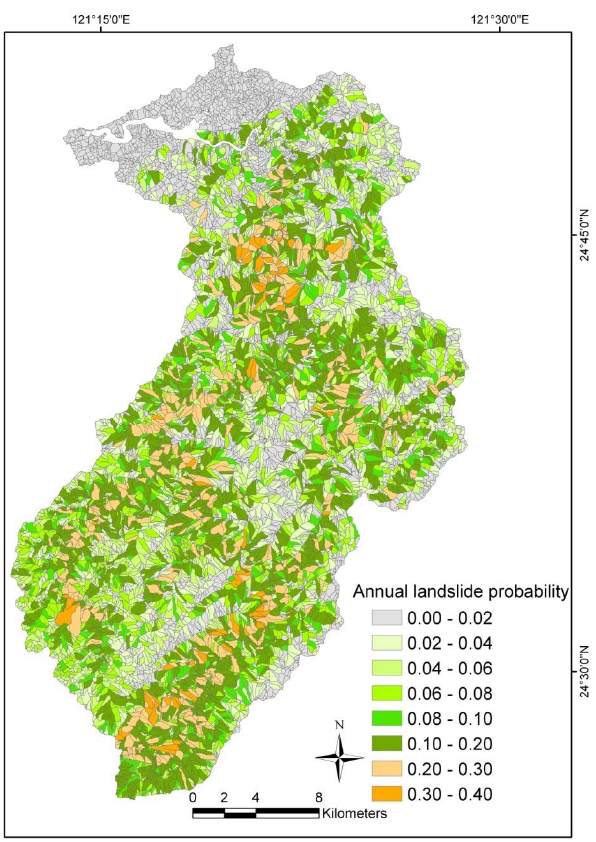
Fig. 12. The difference between the annual landslide probability (Fig. 11) and Poisson landslide probability (Fig. 8). 4